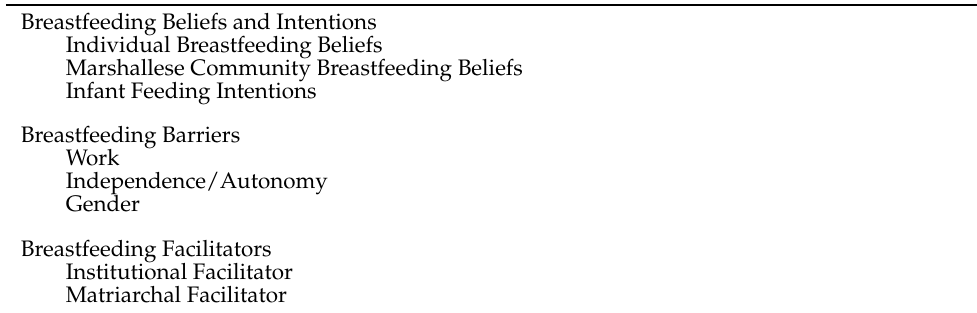
Breastfeeding Beliefs and Intentions Individual